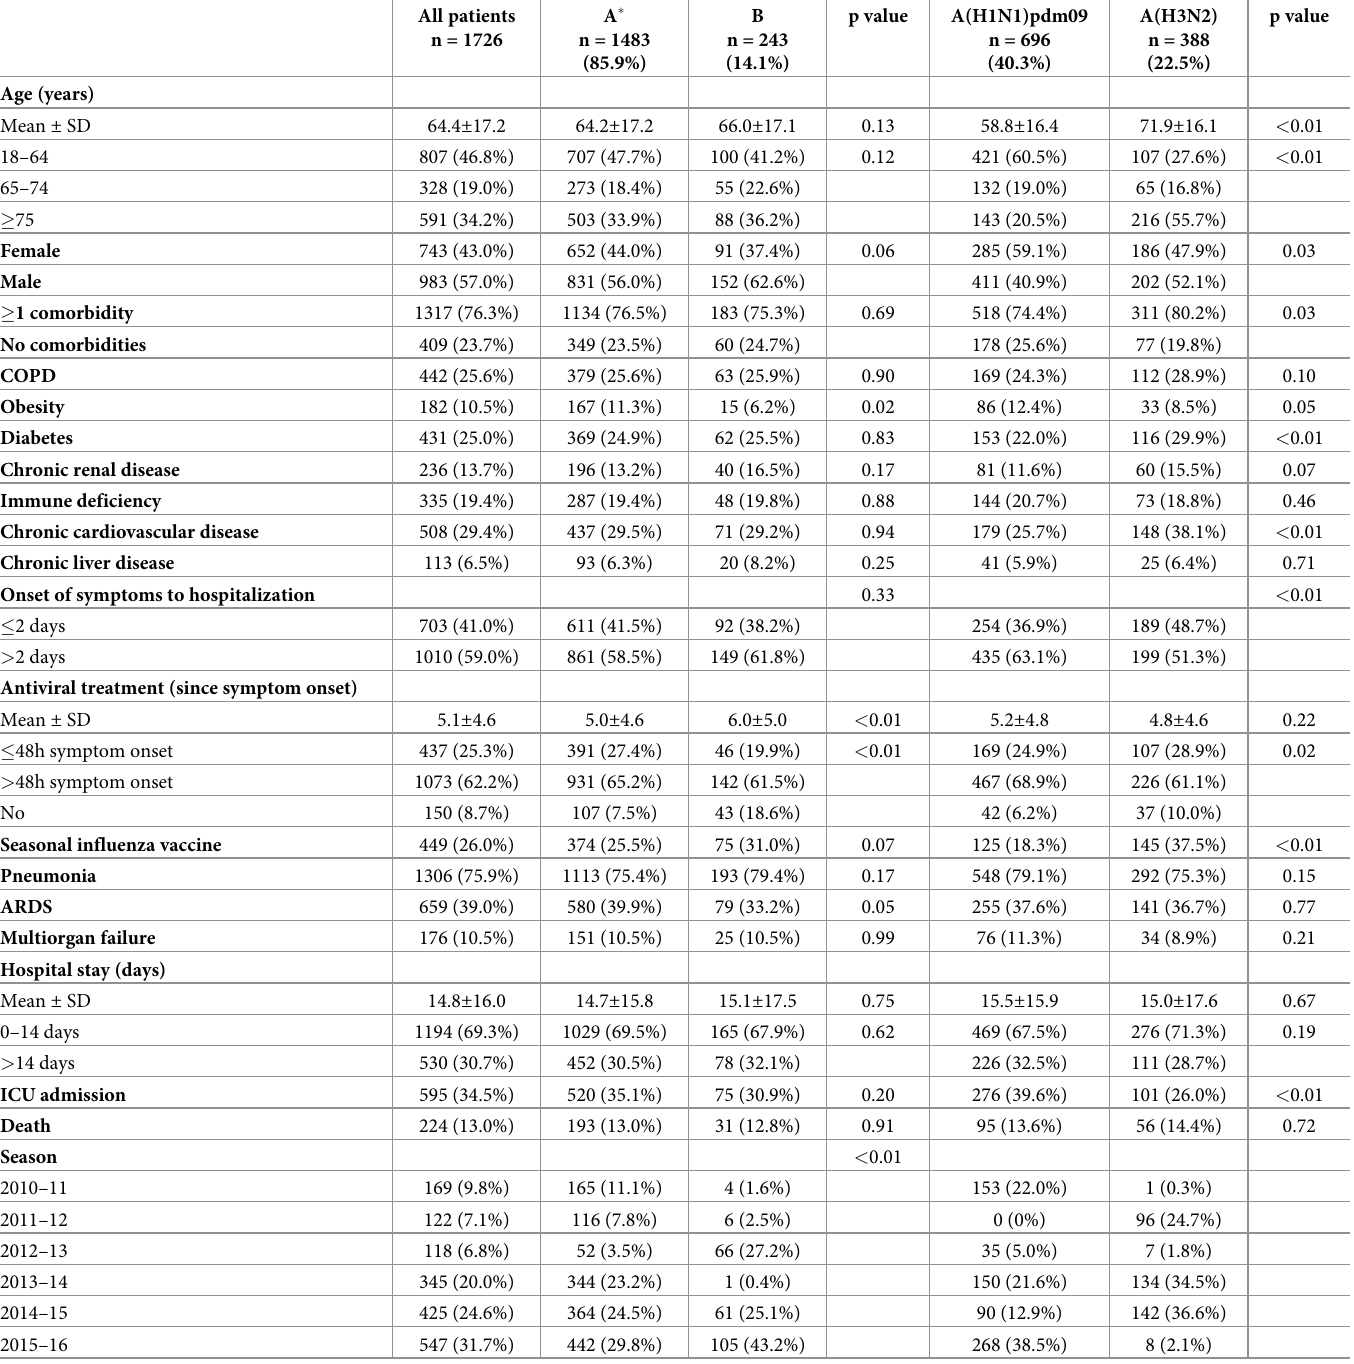
Table 1. Characteristics of all patients hospitalized according to influenza type and